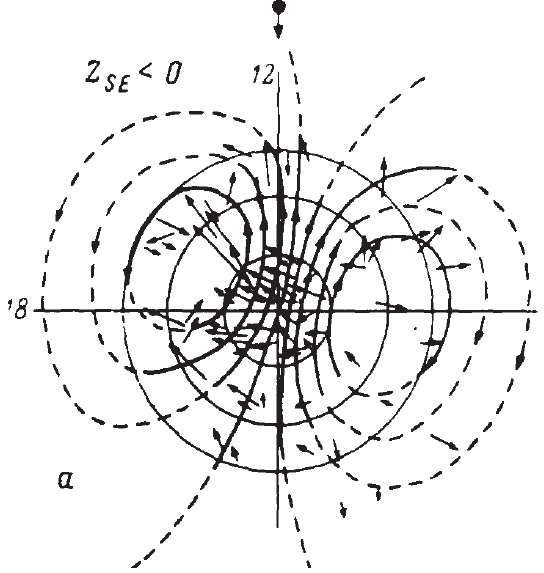
Fig. 1. From Kuznetsov and Troshichev (1975 and 1977). Distri- bution of disturbance vectors in the polar cap and the equivalent current system DP2 ( Z SE < 0). Time shown is in local time. The grey circles represent latitude.